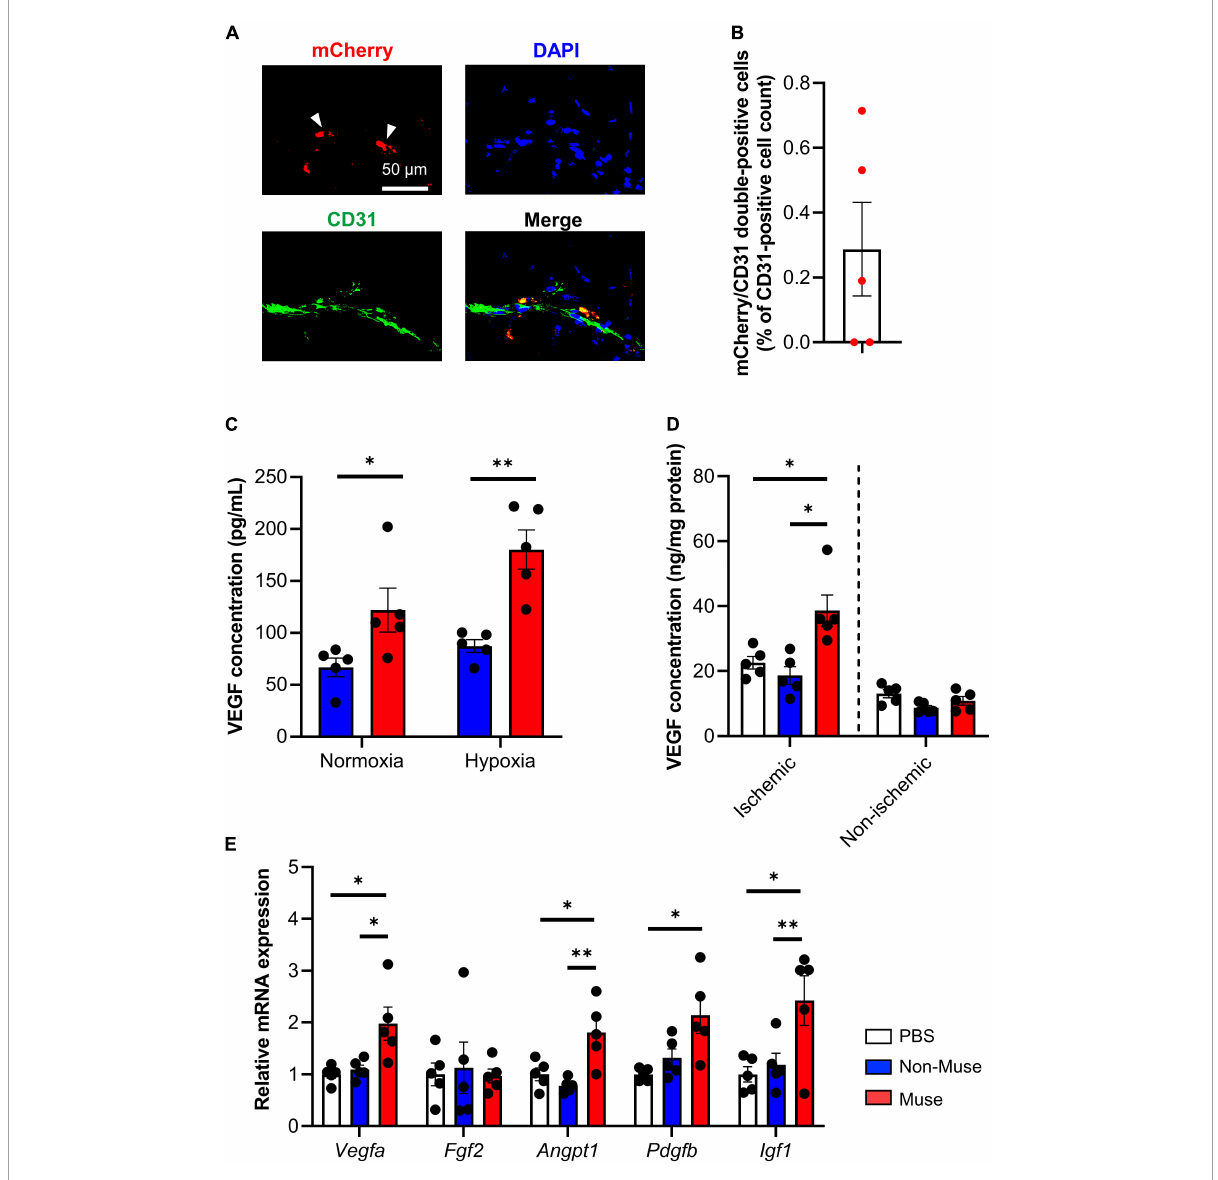
FIGURE3 Angiogenic potential of muse cells. (A) Representative images showing vascular endothelial markers CD31 expression of mCherry-expressing Muse cells in the ischemic adductor muscles at 7 days after hindlimb ischemia (HLI) surgery. Tissue sections were stained with anti-CD31 antibody (green) and 4 (cid:48) 6-diamidino-2-phenylindole (DAPI) (blue). Scale bar, 50 µ m. (B) Flow cytometric analysis of CD31 expression in the ischemic adductor muscles at 7 days after HLI surgery ( n = 5). Results are expressed as mean ± SEM of the percentage of mCherry/CD31 double-positive cells per total CD31-positive cell count in the dissociated ischemic adductor muscle. Dots correspond to each mouse. (C) Vascular endothelial growth factor (VEGF) concentration measured by enzyme-linked immunosorbent assay (ELISA) in the cell culture supernatant of Muse cells or non-Muse mesenchymal stem cells (MSCs) under normoxic and hypoxic conditions. Results are expressed as mean ± SEM ( n = 5). Dots correspond to each biological replicate. (D,E) VEGF concentration measured by ELISA in the adductor muscles (D) and relative mRNA expression of representative angiogenic factors in the ischemic adductor muscle (E) at 7 days after HLI surgery. Muse cells or non-Muse MSCs were intravenously injected 1 day after HLI surgery and phosphate buffered saline was injected as a control. Results are expressed as mean ± SEM ( n = 5). Dots correspond to each mouse. ∗ P < 0.05; ∗∗ P <